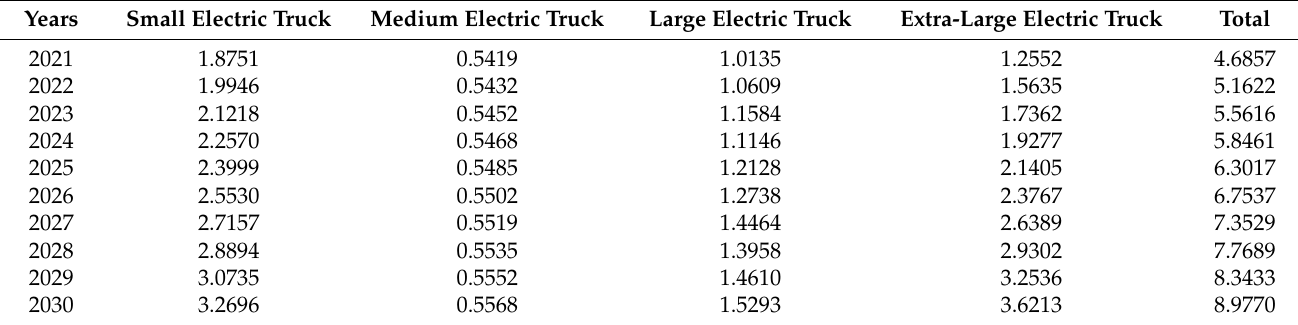
Table 10. Guixin expressway revenue forecast (Unit: Billion